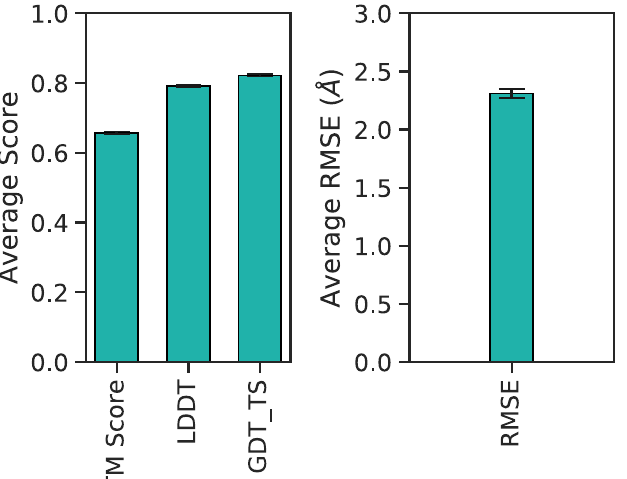
Figure 12. Barplot of average 3D accuracy metrics and corresponding 95% confidence intervals per score